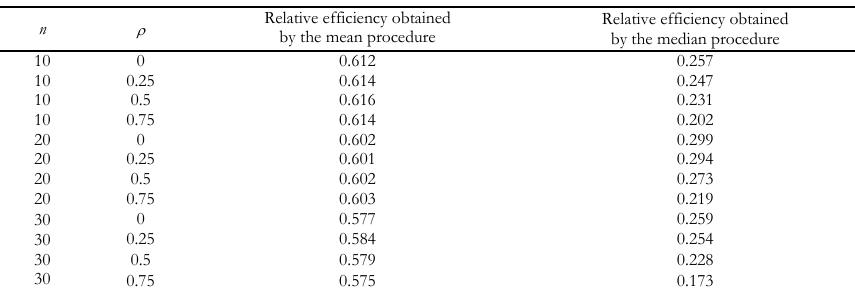
ˆ a obtained by the proposed procedure (means or medians) in comparison Relative efficiencies of 11 with the ordinary least square method Relative efficiency obtained by the mean procedure